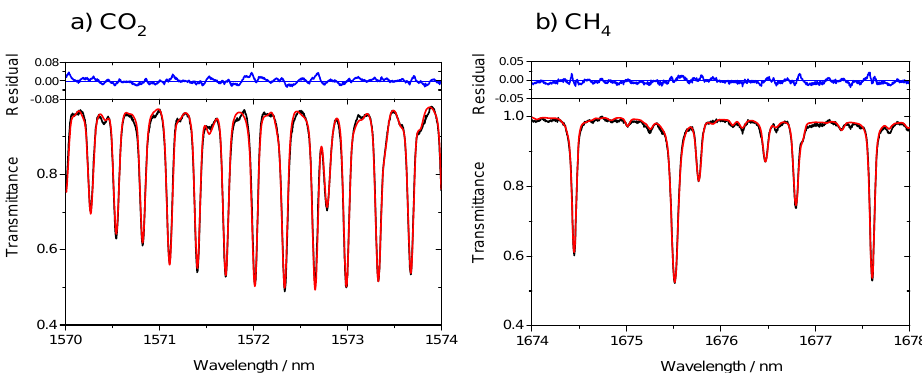
Fig. 2. Absorption spectra of CO 2 and CH 4 . Black and red curves denote the observed and fitted spectra, respectively. The residual is shown in the top panel.